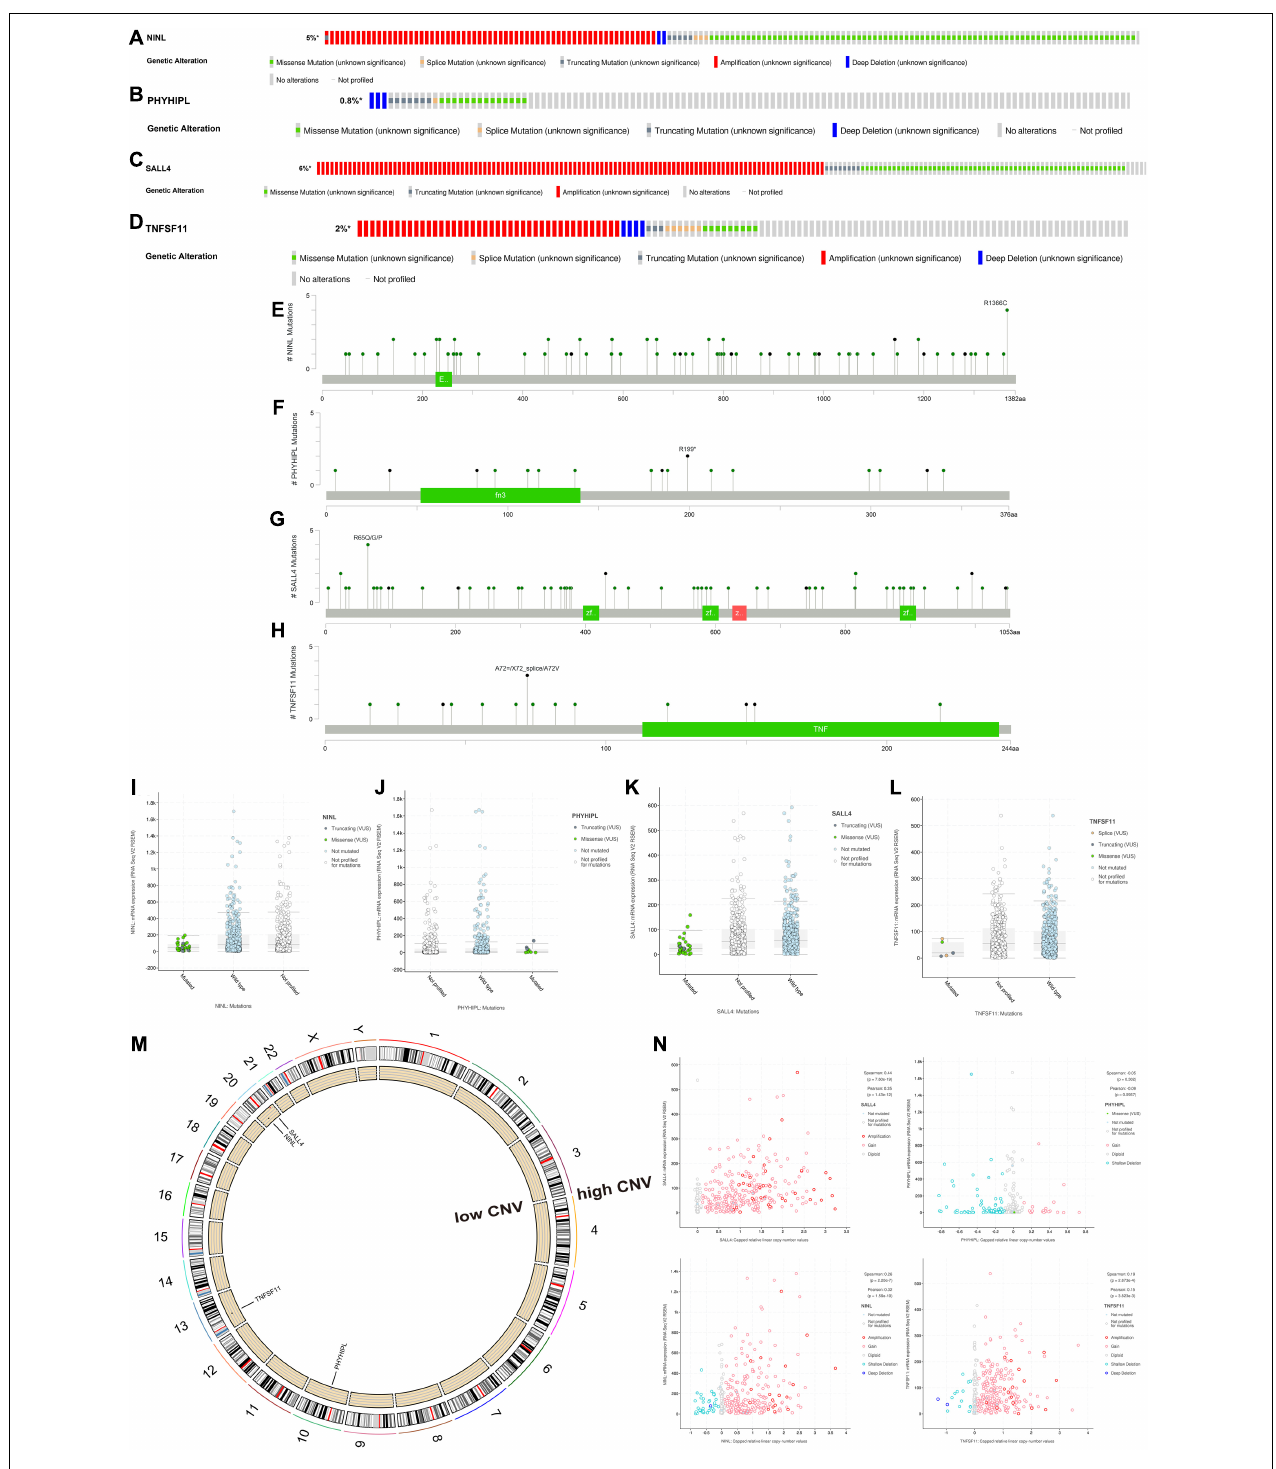
FIGURE 7 | Somatic mutation and copy number variation (CNV) analysis of three lncRNAs ( BOLA3-AS1 , AC124067.4 , AL161772.1 ) and four target mRNAs ( NINL , SALL4 , TNFSF11 , PHYHIPL ). The alteration rates and types of NINL (A) , PHYHIPL (B) , SALL4 (C) , and TNFSF11 (D) . The alteration sits of each gene on the coding protein domains for NINL (E) , PHYHIPL (F) , SALL4 (G) , and TNFSF11 (H) . The comparison of gene expression between wild type and mutated type for NINL (I) , PHYHIPL (J) , SALL4 (K) , and TNFSF11 (L) . (M) The location on a chromosome and the most common CNV status of the four target mRNAs. (N) The association between gene expression and CNV for NINL , PHYHIPL , SALL4 , and TNFSF11 .